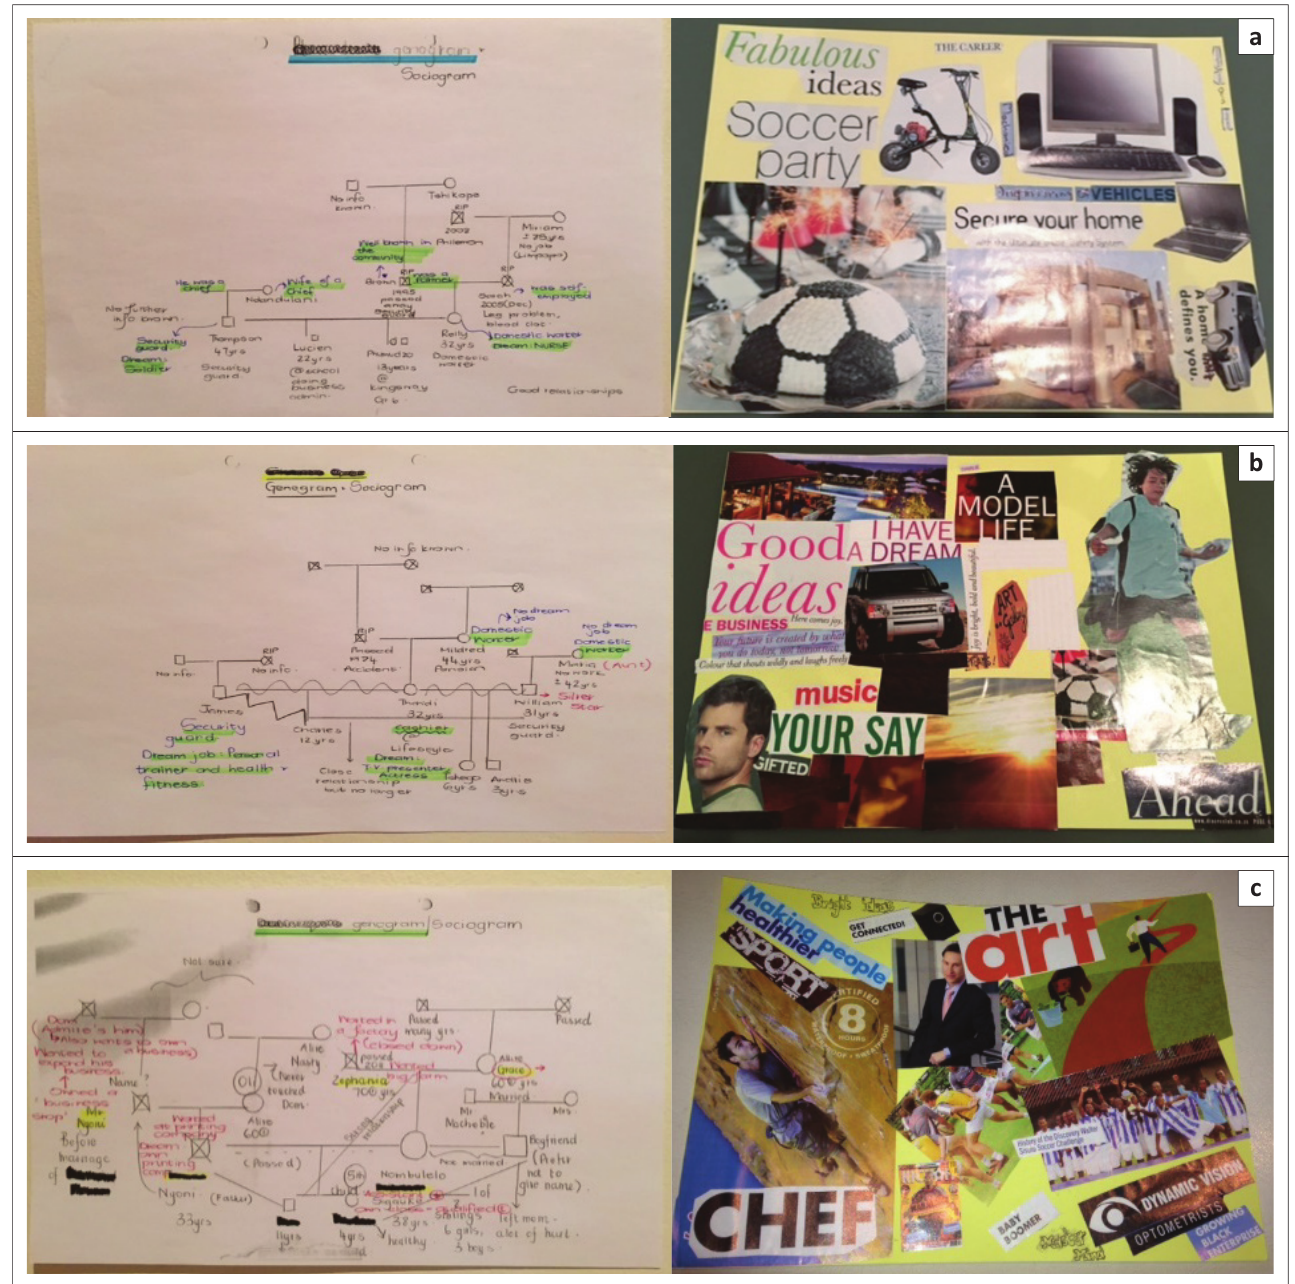
FIGURE 3: Participants’ sociograms and collages. (a) Participant A’s sociogram and collage. (b) Participant B’s sociogram and collage. (c) Participant C’s sociogram and